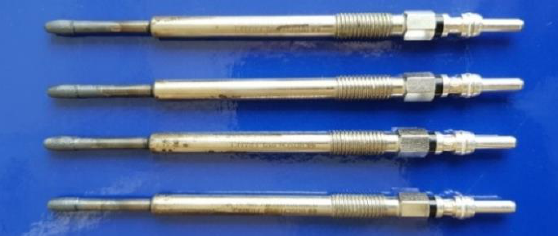
Figure 4. Glow plug with catalytic layer.